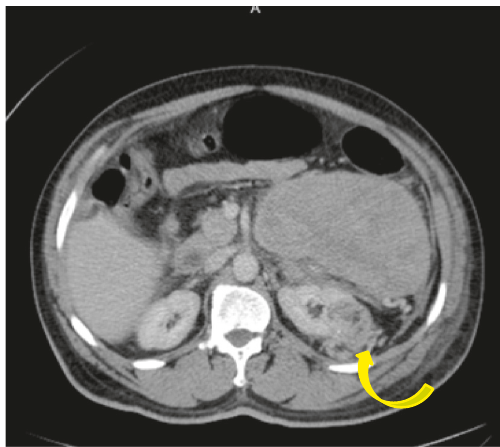
Figure 2: Contrast axial view section shows an ill-defined margin between the exophytic mass and the kidney (curved yellow arrow).